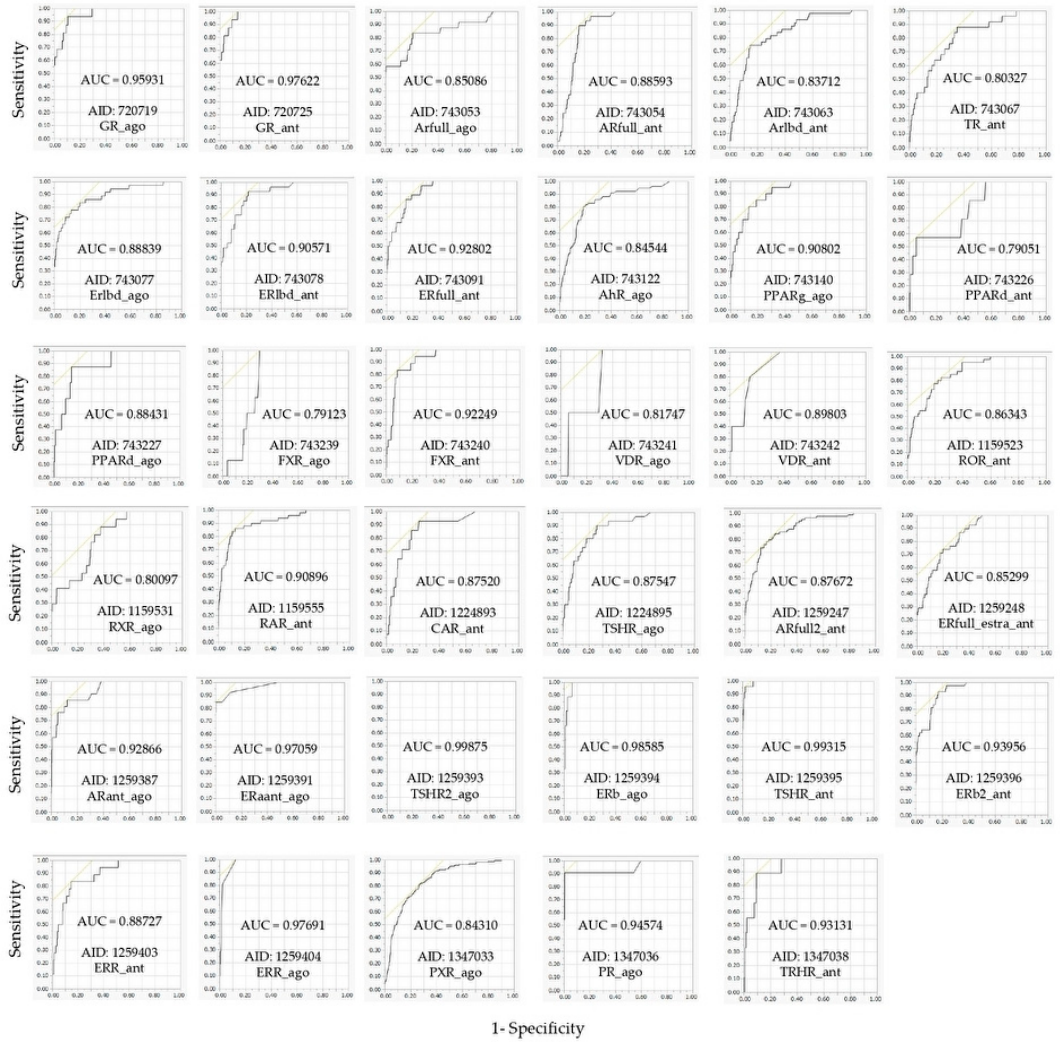
Figure 5. Representative area under the curve of receiver operating characteristic curve (ROC_AUC) in the models of 35 NR agonists and antagonists constructed by DeepSnap-DL.